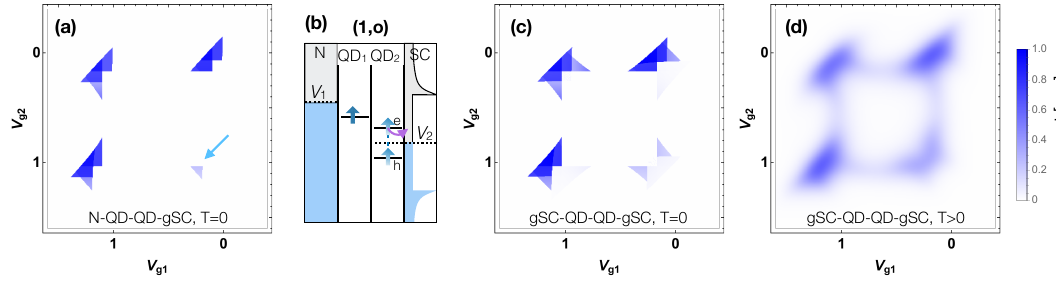
Figure 4: Interplay of Andreev and spin blockade. (a) Charge stability diagram for a N-QD-QD-(gapless SC) system showing a transport pattern consisting of conven- tional transport features, Andreev transport features, and a new feature indicated by the blue arrow. The new feature is a consequence of tunneling process depicted in = 0.01, other parameters are the same as those in Fig. 2b and 2c. (b) Tun- (b). Γ 2 neling process enabled by quasiparticles in the superconducting leads that results in the clearing of the inter-dot triplet. (c) Charge stability diagram for a (gapless SC)- = 0.25, other parameters are the same as those in QD-QD-(gapless SC) system. ∆ 1 panel (a). (d) Same as (c) but at T = 0.05 U 1